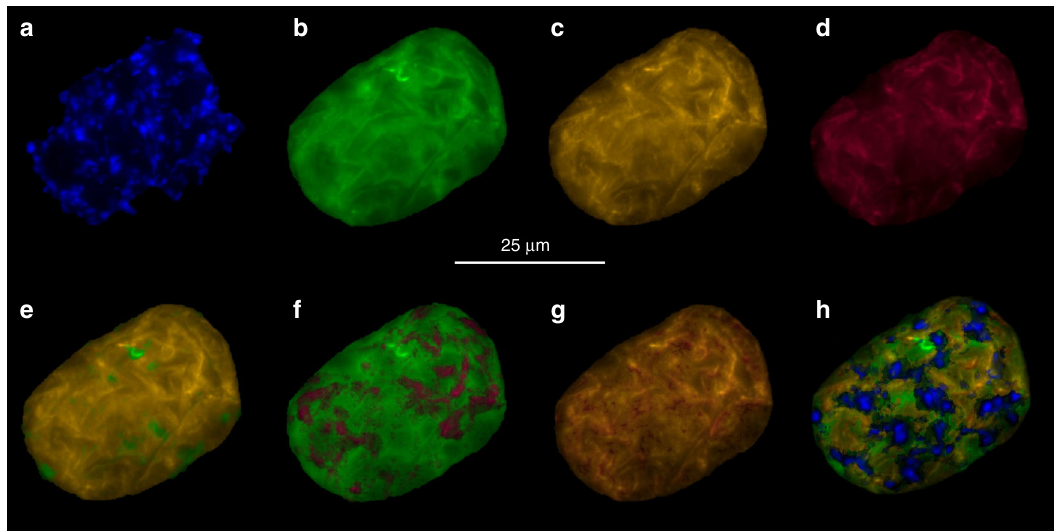
Fig. 3 Fluorescence in situ hybridization. Fluorescence in situ hybridization of a DAPI stained a Achromatium cell using probes AchroCLII-IV (5 ′ -cgatcgtcgccttggtaggctt-3 ′ ) b , AchroCLIII (5 ′ -cgatcgttgccttggtgggctt-3 ′ ) c , and AchroCLI (5 ′ -ggatcgtcgccttggtaggcca-3 ′ ) d . The used three different probes for Achromatium match the clusters in Supplementary Fig. 2A. e – g Show overlaid images of 2 probes combinations. An overlay of all probes as well as the DAPI staining is shown in h . Results from additional cells are shown in Supplementary Fig.